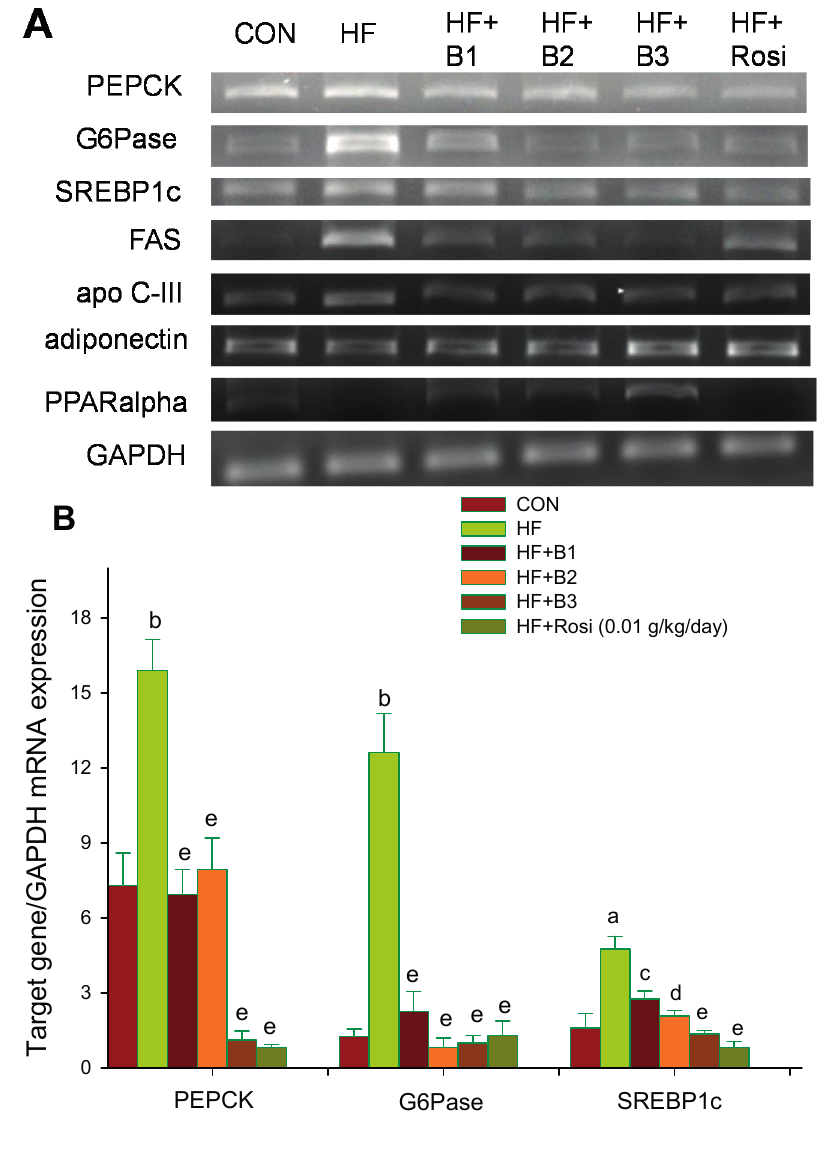
Figure 4. Semiquantative RT-PCR analyses including ( A ) image; ( B ) and ( C ) statistical data for phosphenolpyruvate carboxykinase (PEPCK), glucose-6-phosphatase (G6Pase), sterol regulatory element binding protein 1c (SREBP1c), fatty acid synthase (FAS), apo C-III, adiponectin and peroxisome proliferator-activated receptor α (PPAR α ) mRNA expression in liver tissue of the mice by oral gavage extracts of Bofu-tsusho-san (BO) or Rosi: rosiglitazone (0.01 g/kg body weight) or vehicle for 4 weeks. Total RNA (1 μ g) isolated from tissue was reverse transcripted by MMLV-RT, 10 μ L of RT products were used as templates for PCR. The expression levels of PEPCK, G6Pase, DGAT2, SREBP1c, PPAR α , FAS, apo C-III and adiponectin mRNA were measured and quatified by image analysis. Values were normalized to GAPDH mRNA expression. All values are means ± S.E. ( n = 9). a p < 0.01, b p < 0.001 compared with the control (CON) group; c p < 0.05, d p < 0.01, e p < 0.001 compared with the high-fat + vehicle (distilled water) (HF) group by ANOVA. B1, B2, B3, extract granules of BO (0.015, 0.075 and 0.150 g/kg body